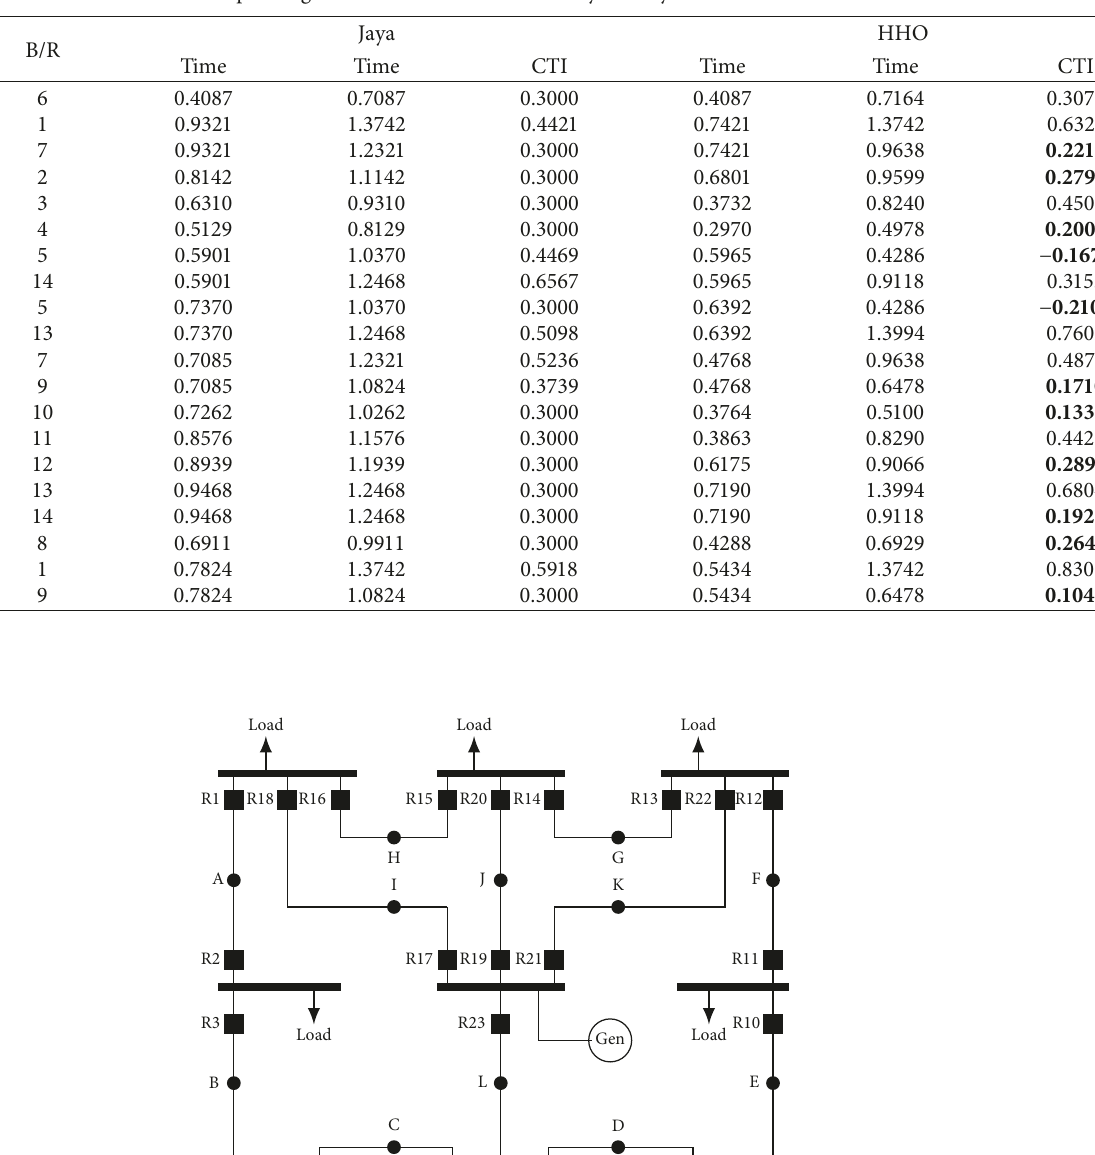
Table 13: Operating time and CTI for the 8-bus system by MINLP formulation.